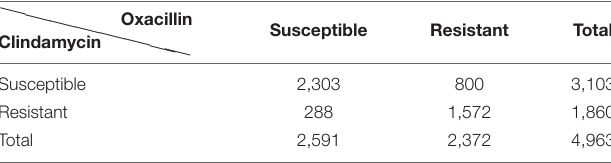
Frontiers in Microbiology |